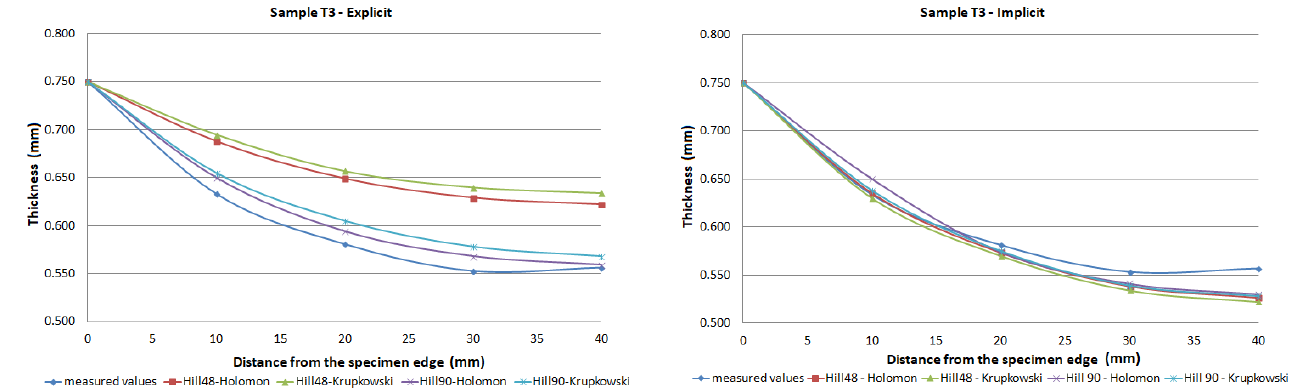
Figure 14. Comparison of predicted and measured thickness values of sample T3 using different types of yield criteria, hardening laws and integration scheme.